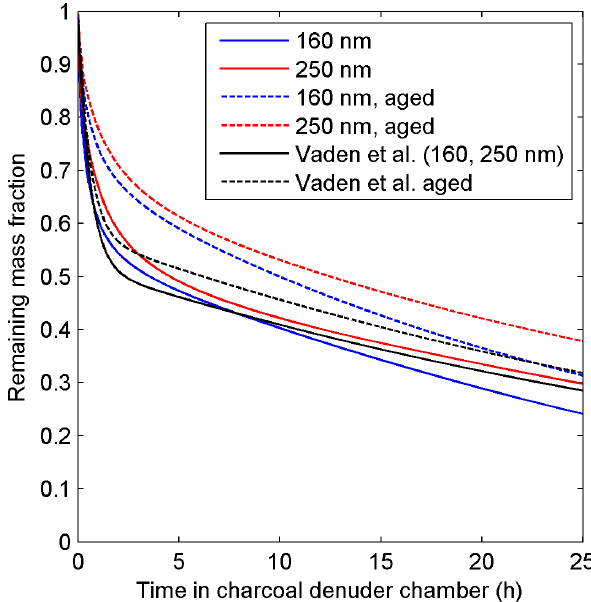
Figure 6. Measured (Vaden et al., 2011) and modelled evap- oration losses for particles composed of approximately equal amount of dimer and monomer SOA prior to introduction to the charcoal denuder chamber. The saturation vapour pressures were calculated with SIMPOL, D 0 , monomer = 2 × 10 − 14 cm 2 s − 1 , D dimer = 2 × 10 − 16 cm 2 s − 1 , k f = 10 − 23 molecules − 1 cm 3 s − 1 , k d = 1 / 10h − 1 , no phase separation and k ∗ g , w = 1 / 2000s − 1 . The results are given both for fresh and aged particles with a diameter of ∼ 160 and ∼ 250nm,